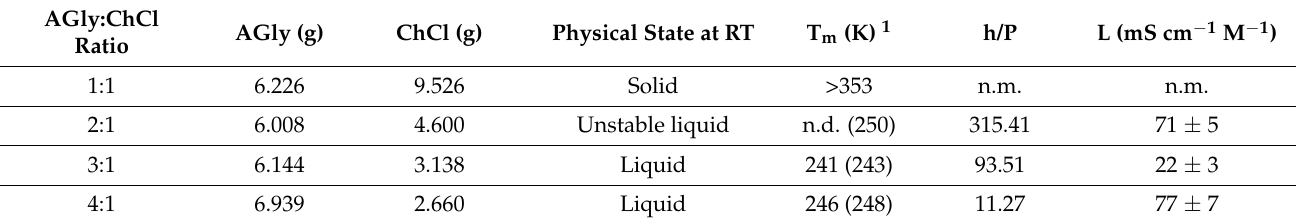
Table 1. Physical and chemical data of AGly:ChCl